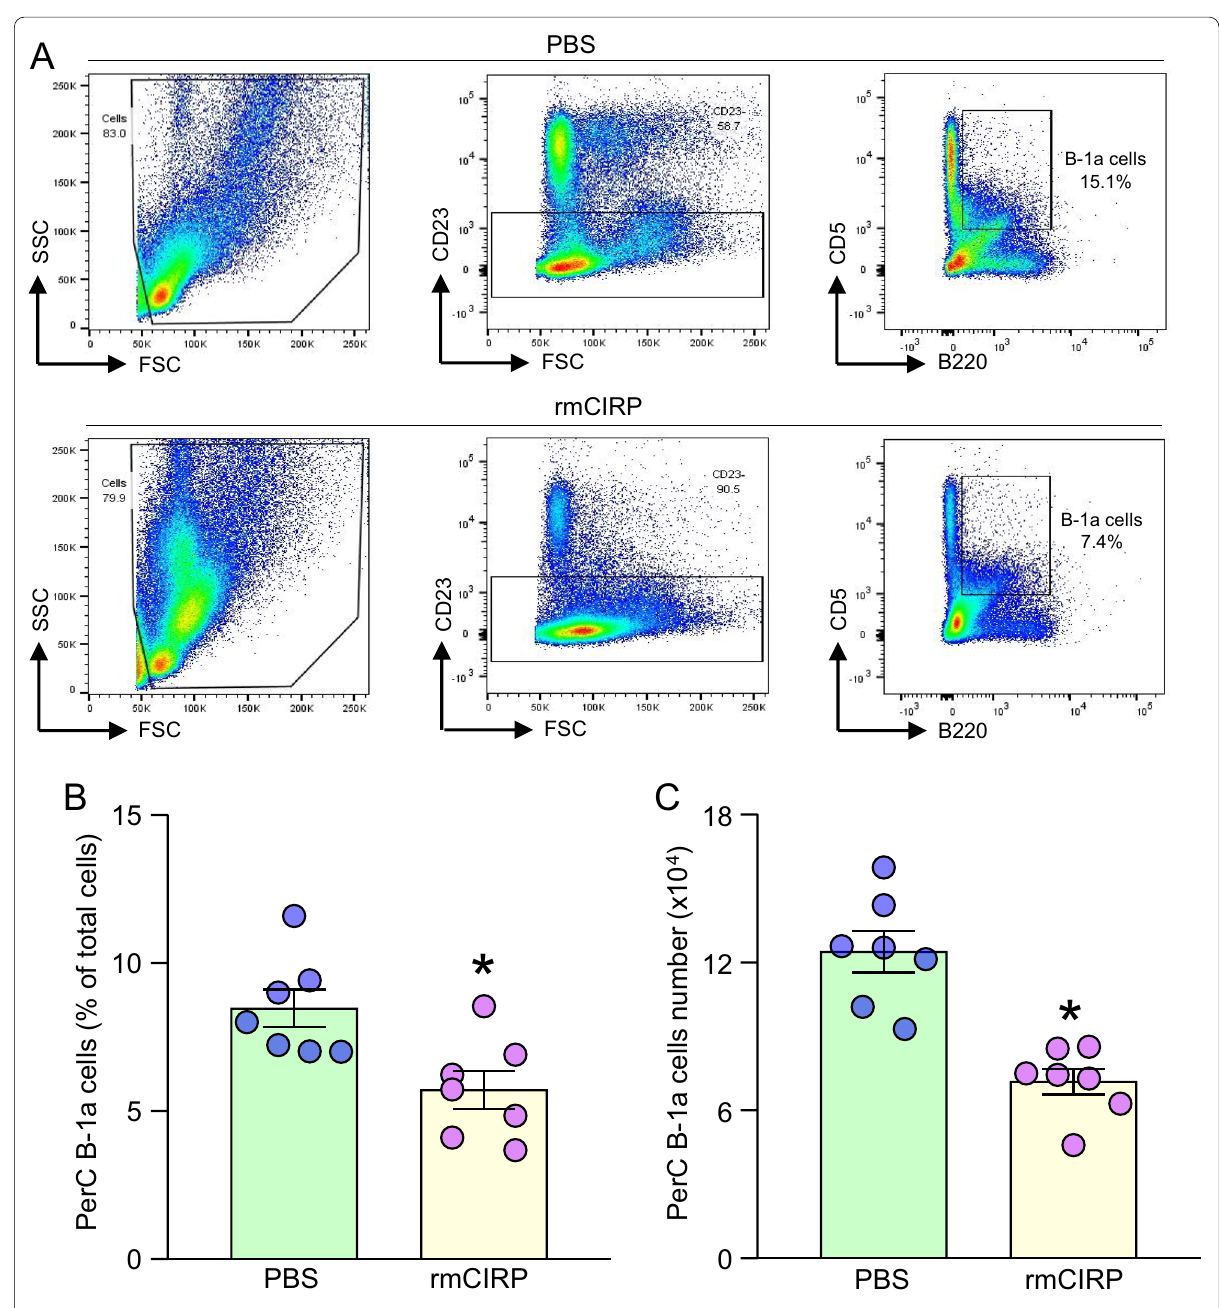
Fig. 3 Intraperitoneal injection of rmCIRP results in a loss of B-1a cells from the PerC. A After 20 h of i.p. injection of rmCIRP in mice, PerC lavage samples were collected. Peritoneal cells were stained with CD23, B220, and CD5 Abs and subjected to flow cytometric detection of B-1a cells frequencies. Representative dot blots of the gating strategy of B-1a cells of vehicle and rmCIRP treated mice are shown. B, C Status of B-1a cell’s frequencies and numbers after i.p. injection of PBS vehicle or rmCIRP are shown. Data are expressed as means groups were compared by Student’s t-test (*p < 0.05 vs. vehicle-treated